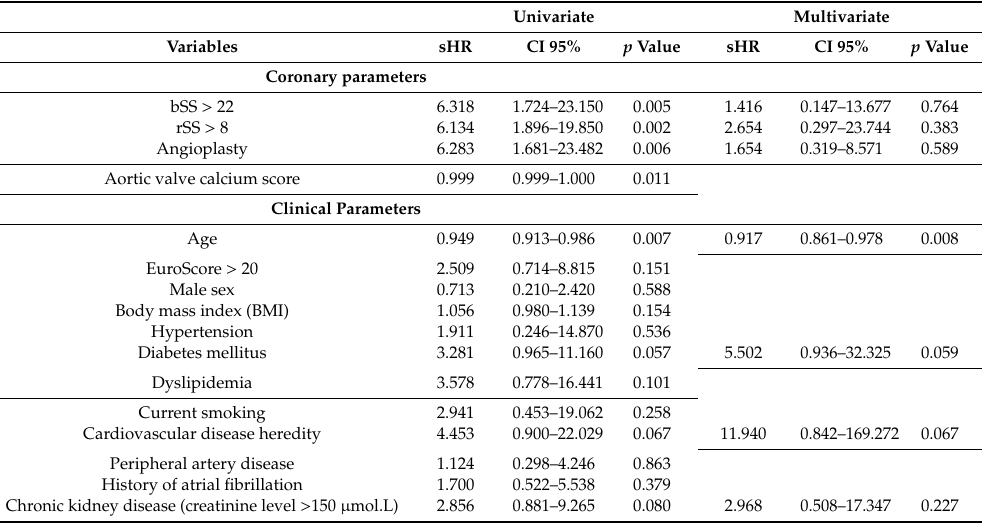
Table 4. Predictors of myocardial infarction.